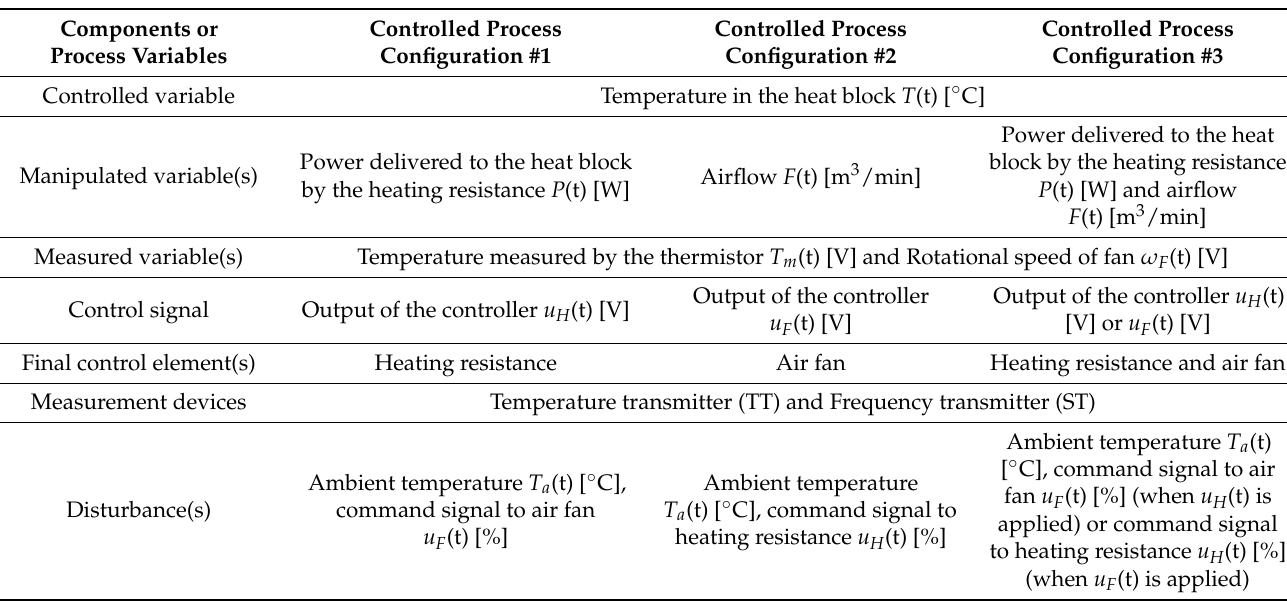
Table 2. Main components and process variables depending on the controlled process